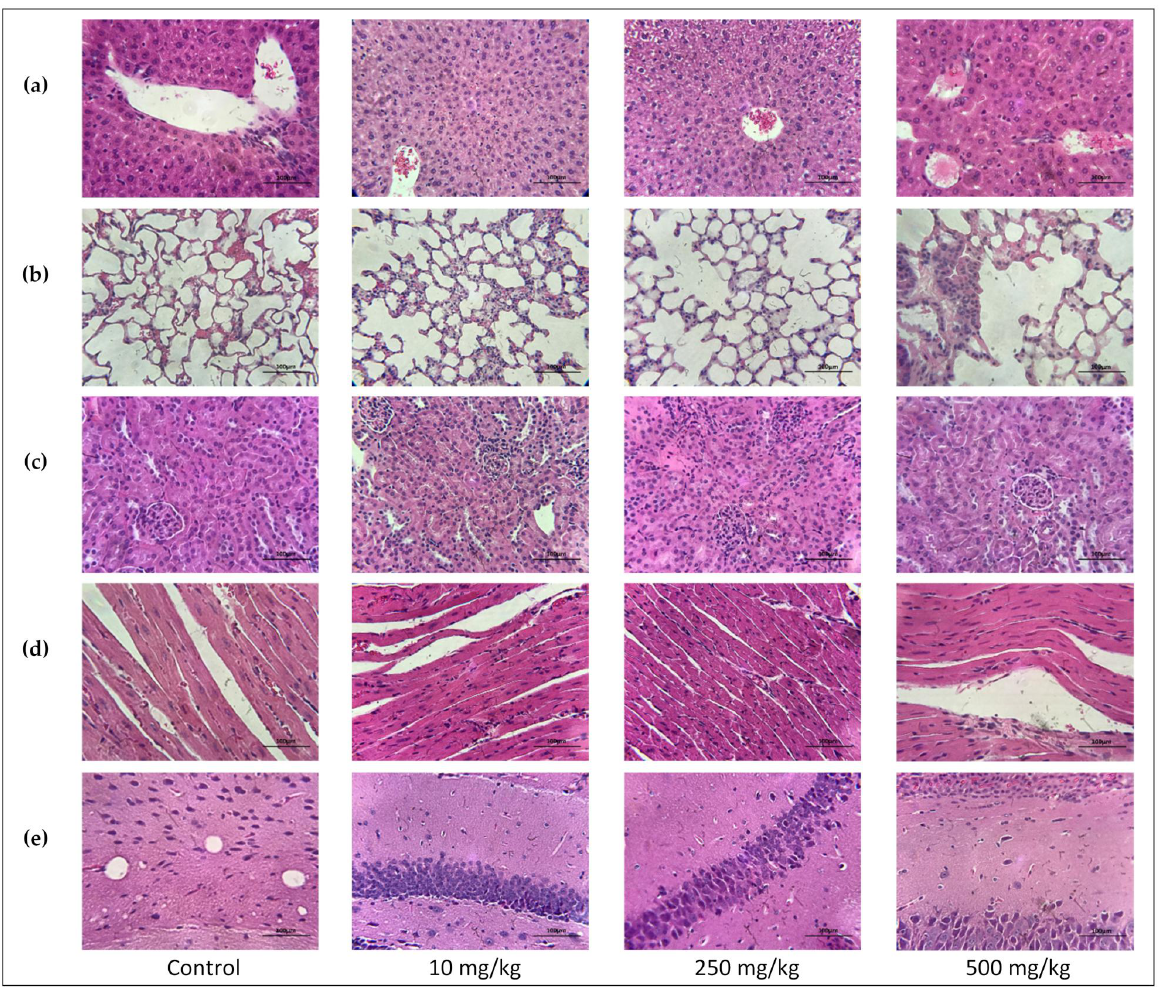
Figure 9. Histopathological examination of Swiss albino female mice organs treated with PsA single oral doses. ( a ) H&E-stained liver sections. ( b ) H&E-stained bronchiolar sections. ( c ) H&E-stained renal cortex sections. ( d ) H&E-stained cardiac muscle sections. ( e ) H&E-stained hippocampal sections. All section images taken at 400× magnification.